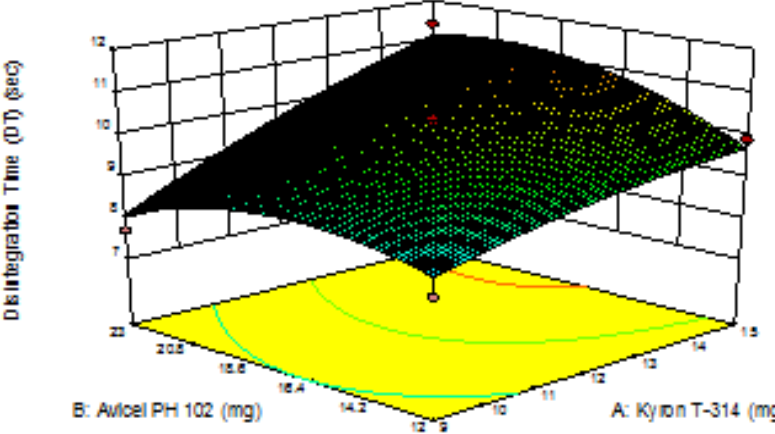
Figure 4. Contour plot of FDTs of